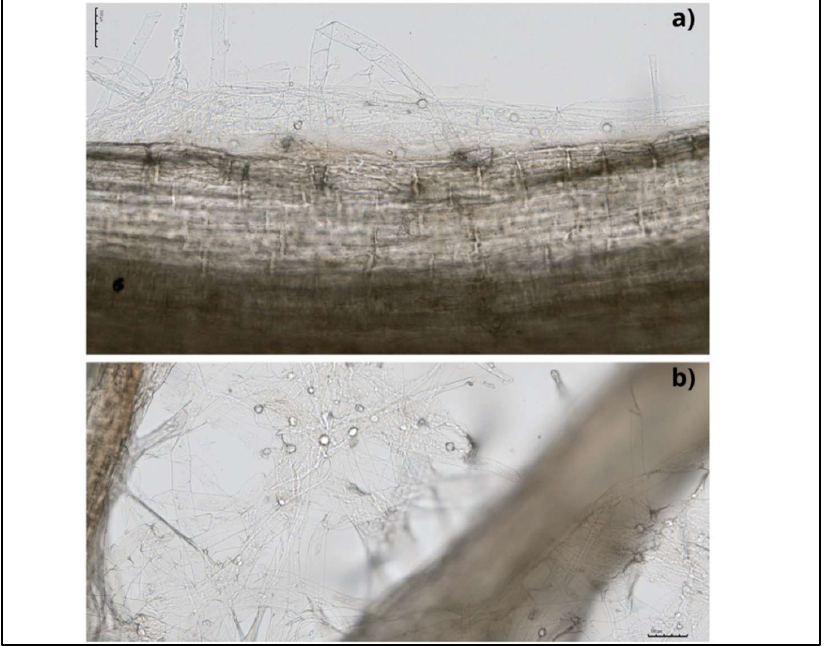
Figure 3. Bright-field microscope photos of the cabbage roots with internal ( a ) and external ( b ) colonisation by S. indica ; scale bars of 100 µm.